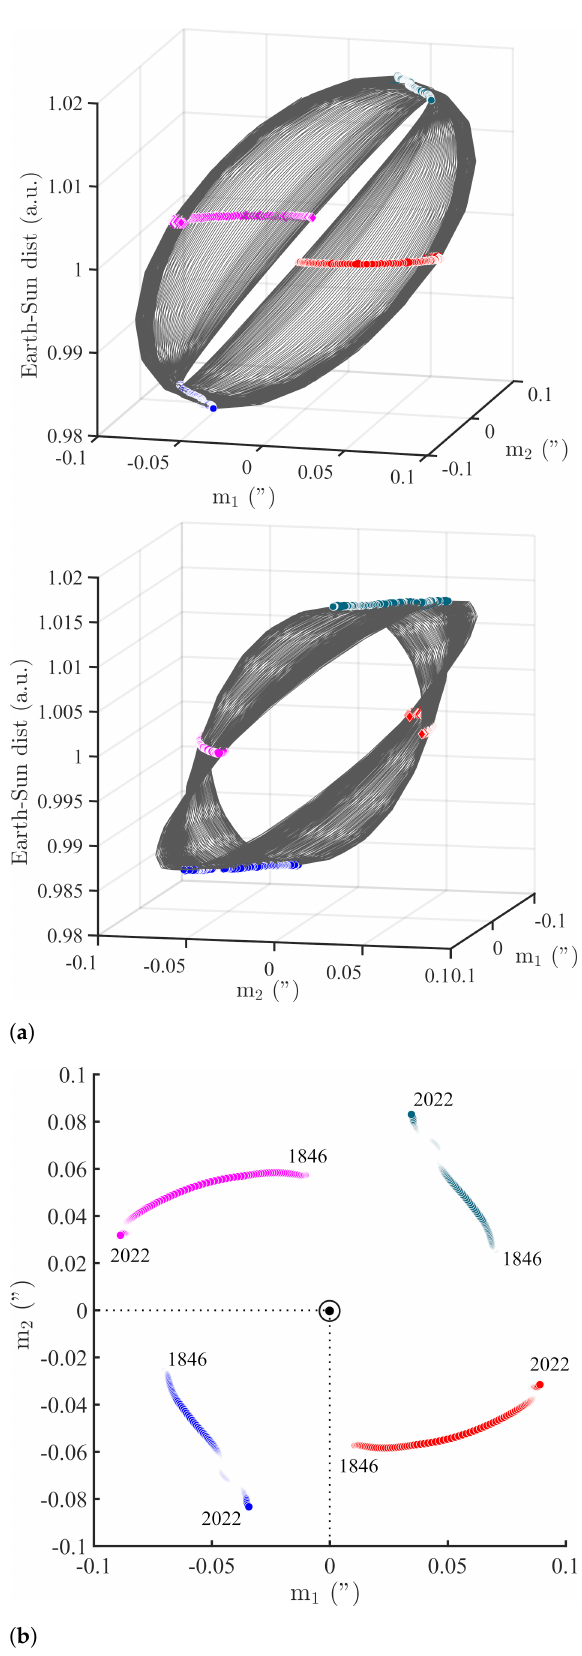
Figure 5. Drift of equinoxes and solstices since 1846. ( a ) Lissajous diagram for the couple of rotation pole motion coordinates ( m 1 , m 2 ) as they vary with Sun–Earth distance, i.e., as a function of time. ( b ) Projection of the drift of equinoxes and solstices from 1846 to the present in the ( m 1 , m 2 )